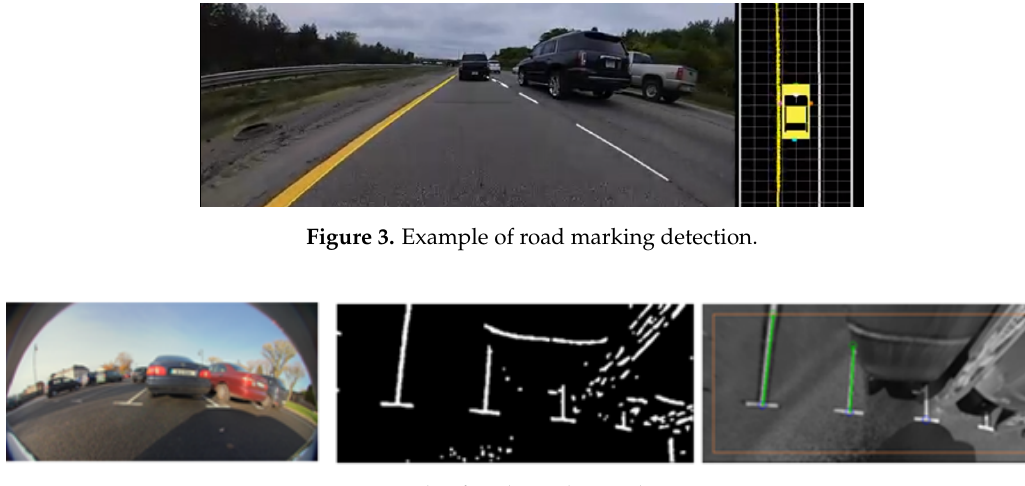
Figure 4. Example of parking slot marking